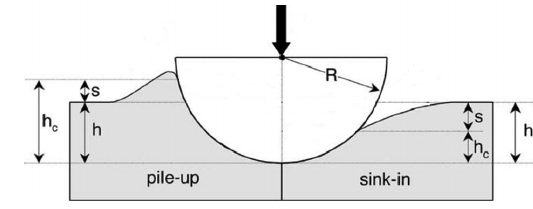
Figure 1. Cross section of an indentation profile showing the ball radius (R), contact depth (hC), pile-up depth (s) and indentation depth at maximum load (h).